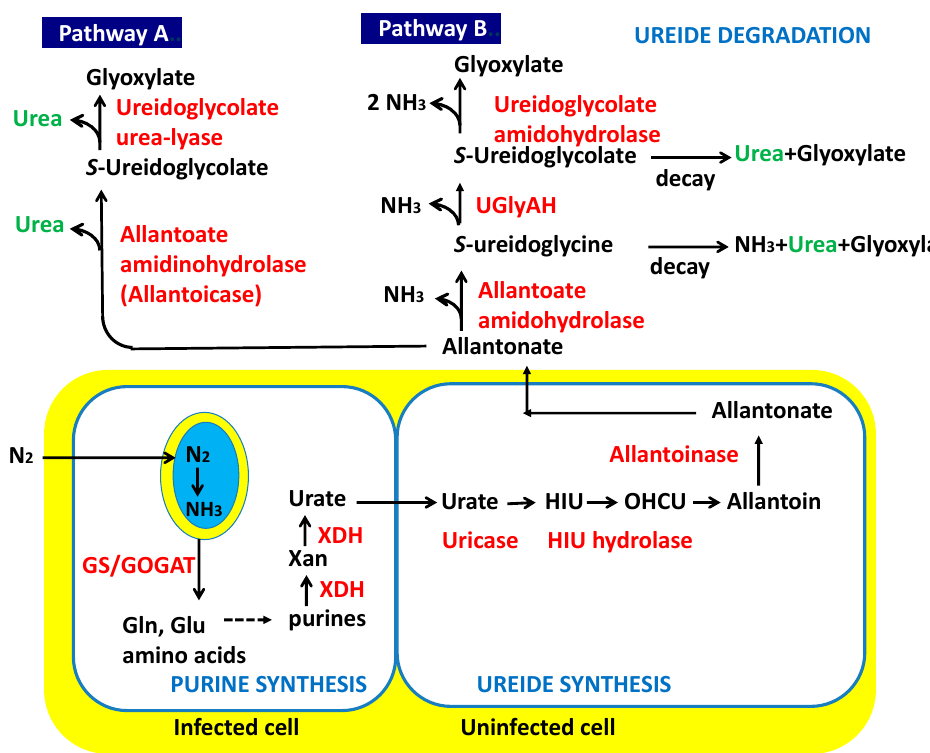
Figure 1. A model of ureide synthesis in the nodules and ureide degradation in soybean. GS: glutamine synthetase; GOGAT: glutamate synthase; XDH: xanthine dehydrogenase; Xan: xanthine; HIU: hydroxyisourate; OHCU: 2-oxo-4-hydroxy-4-carboxy-5-ureidoimidazoline; UGlyAH: ureidoglycine aminohydrolase.